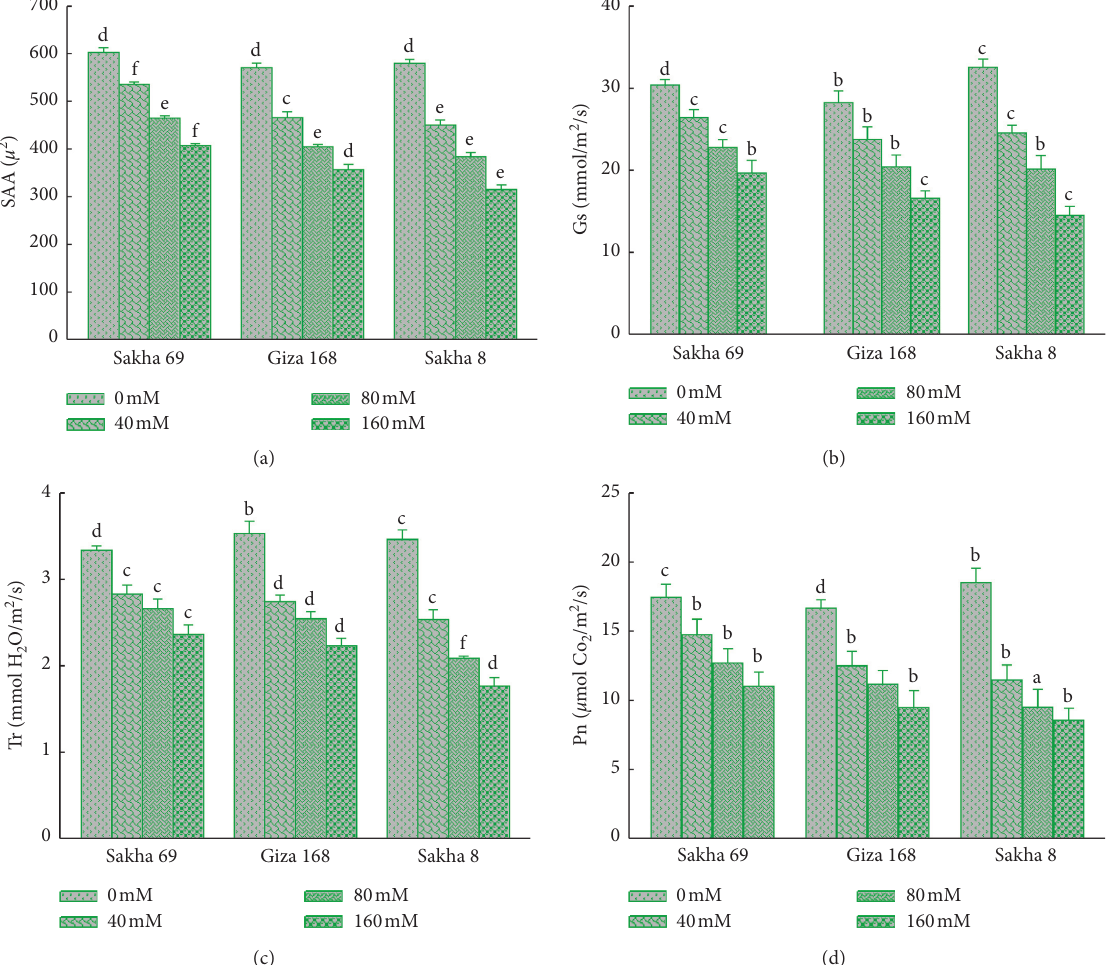
Figure 3: Gas exchange parameters and stomatal aperture area responses to salinity (0, 40, 80, and 160Mm) of wheat cultivars: (a) stomata aperture area (SAA); (b) stomatal conductance (Gs); (c) transpiration rate (Tr); (d) photosynthetic rate (Pn). Each column symbolizes mean ± SE ( n � 3). Means and standard errors are demonstrated by error bars. Letters point out significant differences at p < 0 .